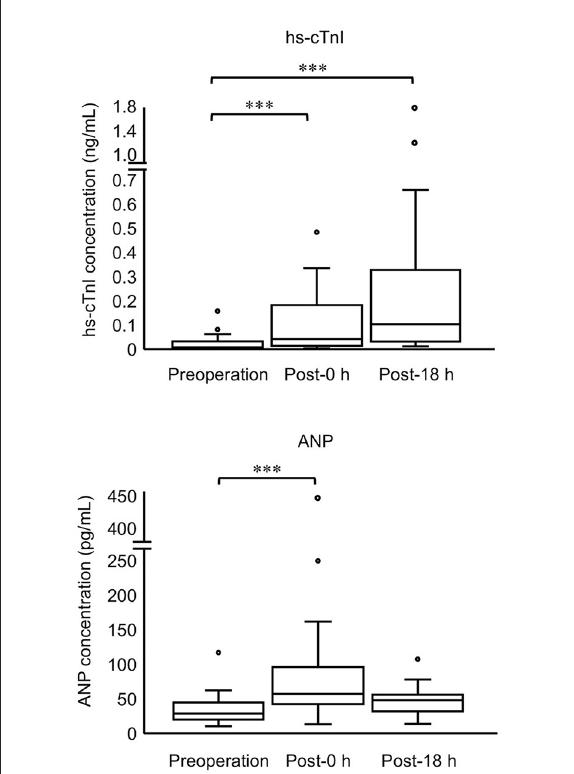
FIGURE1 Concentrations of hs-cTnI and ANP in all cats at three measurement points (preoperation, 0h postoperation, and 18h postoperation). The top and bottom of the box represent the 75th and 25th percentiles, respectively; middle line, median; whiskers, highest and lowest data points within 1.5 times the length of the quartiles; and circles, outliers. Data of hs-cTnI and ANP are not normally distributed (non-parametric data). Asterisks indicate statistical difference (*** P <